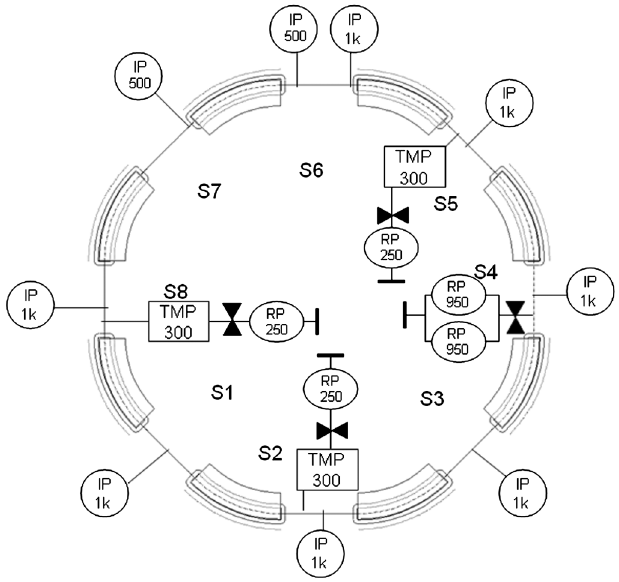
FIG. 26. Overview of the DA ring vacuum system. RP, TMP, and IP denote a rotary pump, turbo molecular pump, and ion getter pump, respectively. The numbers after the pump type are their pumping speed ( l = min ).